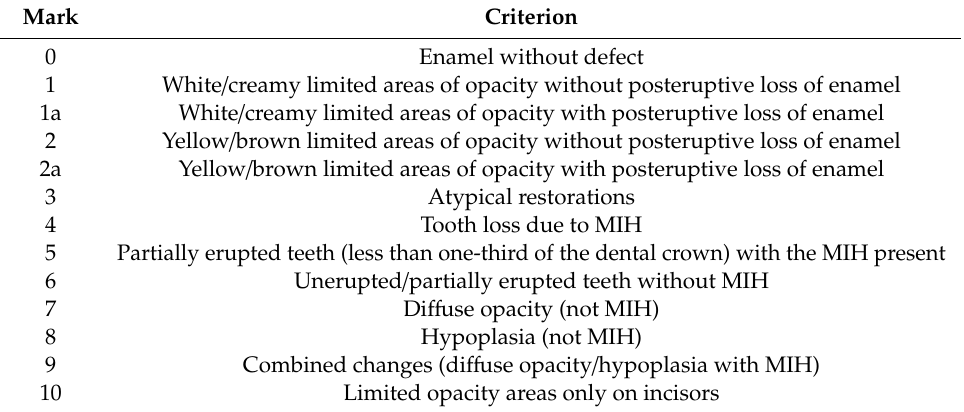
Table 1. Criteria for determining molar–incisor hypomineralization (MIH) according to the European Academy of Paediatric Dentistry